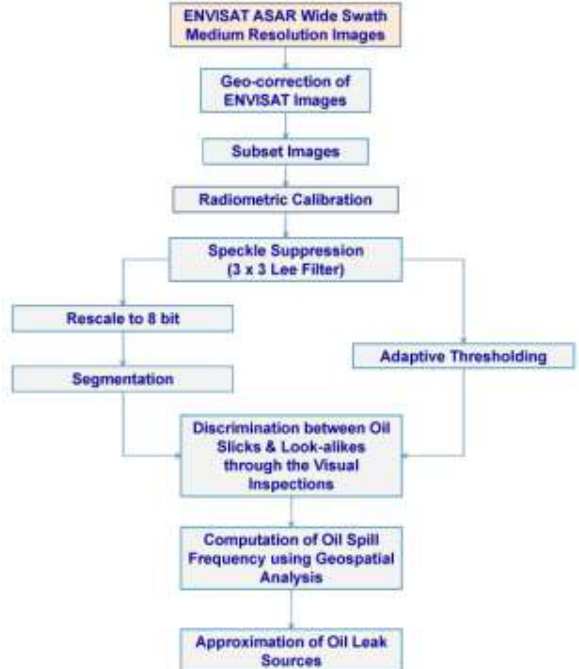
Figure 7. Workflow for the Detection of Oil Spills, Computation of Frequencies & Approximation of Oil Leak